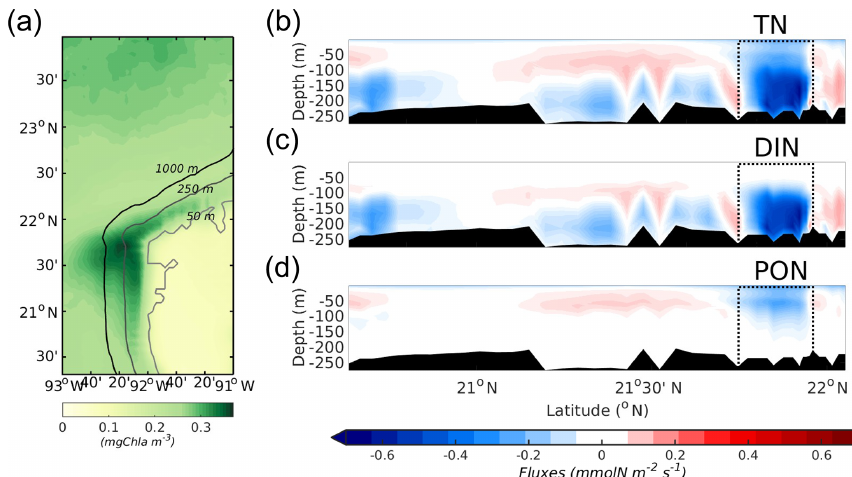
Figure 10. (a) Map of surface chlorophyll (mgChlm − 3 ), averaged over the 9 simulated years. The three characteristic isobaths are de- noted. A total of 9 years of averaged cross-shelf fluxes along the 250m isobath at the western boundary of (b) TN, (c) DIN, and (d) PON (mmolNm − 2 s − 1 ). Negative values indicate westward flux, i.e. TN flux from the shelf to the Campeche Bay. The area delimited by dashed lines shows the location of the filament depicted in (a) , in the NW of the YS.